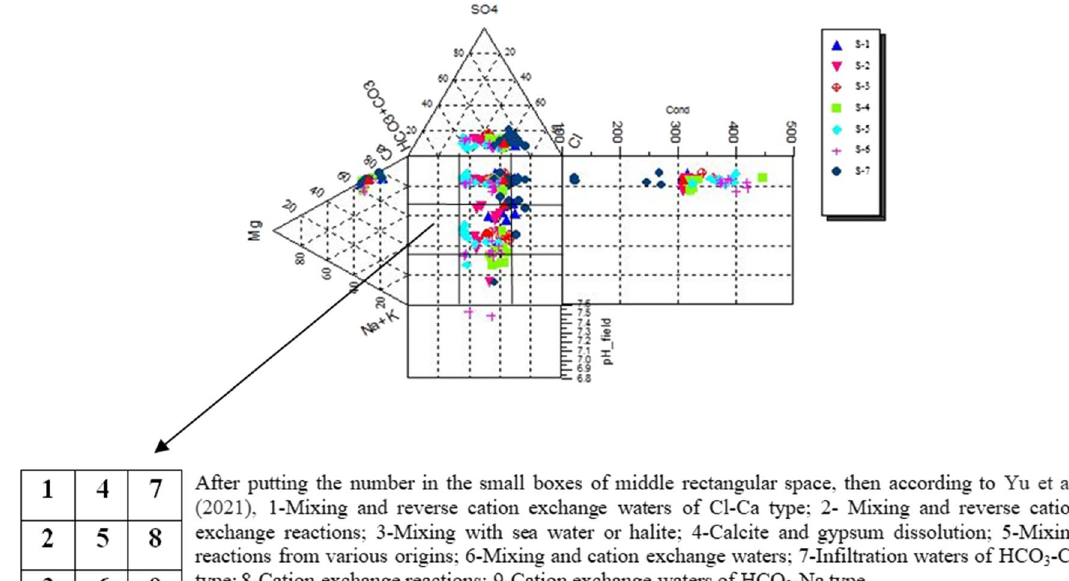
Fig. 6 Durov’s diagram showing the type of irrigation water chemistry at high altitude (Leh, Ladakh,